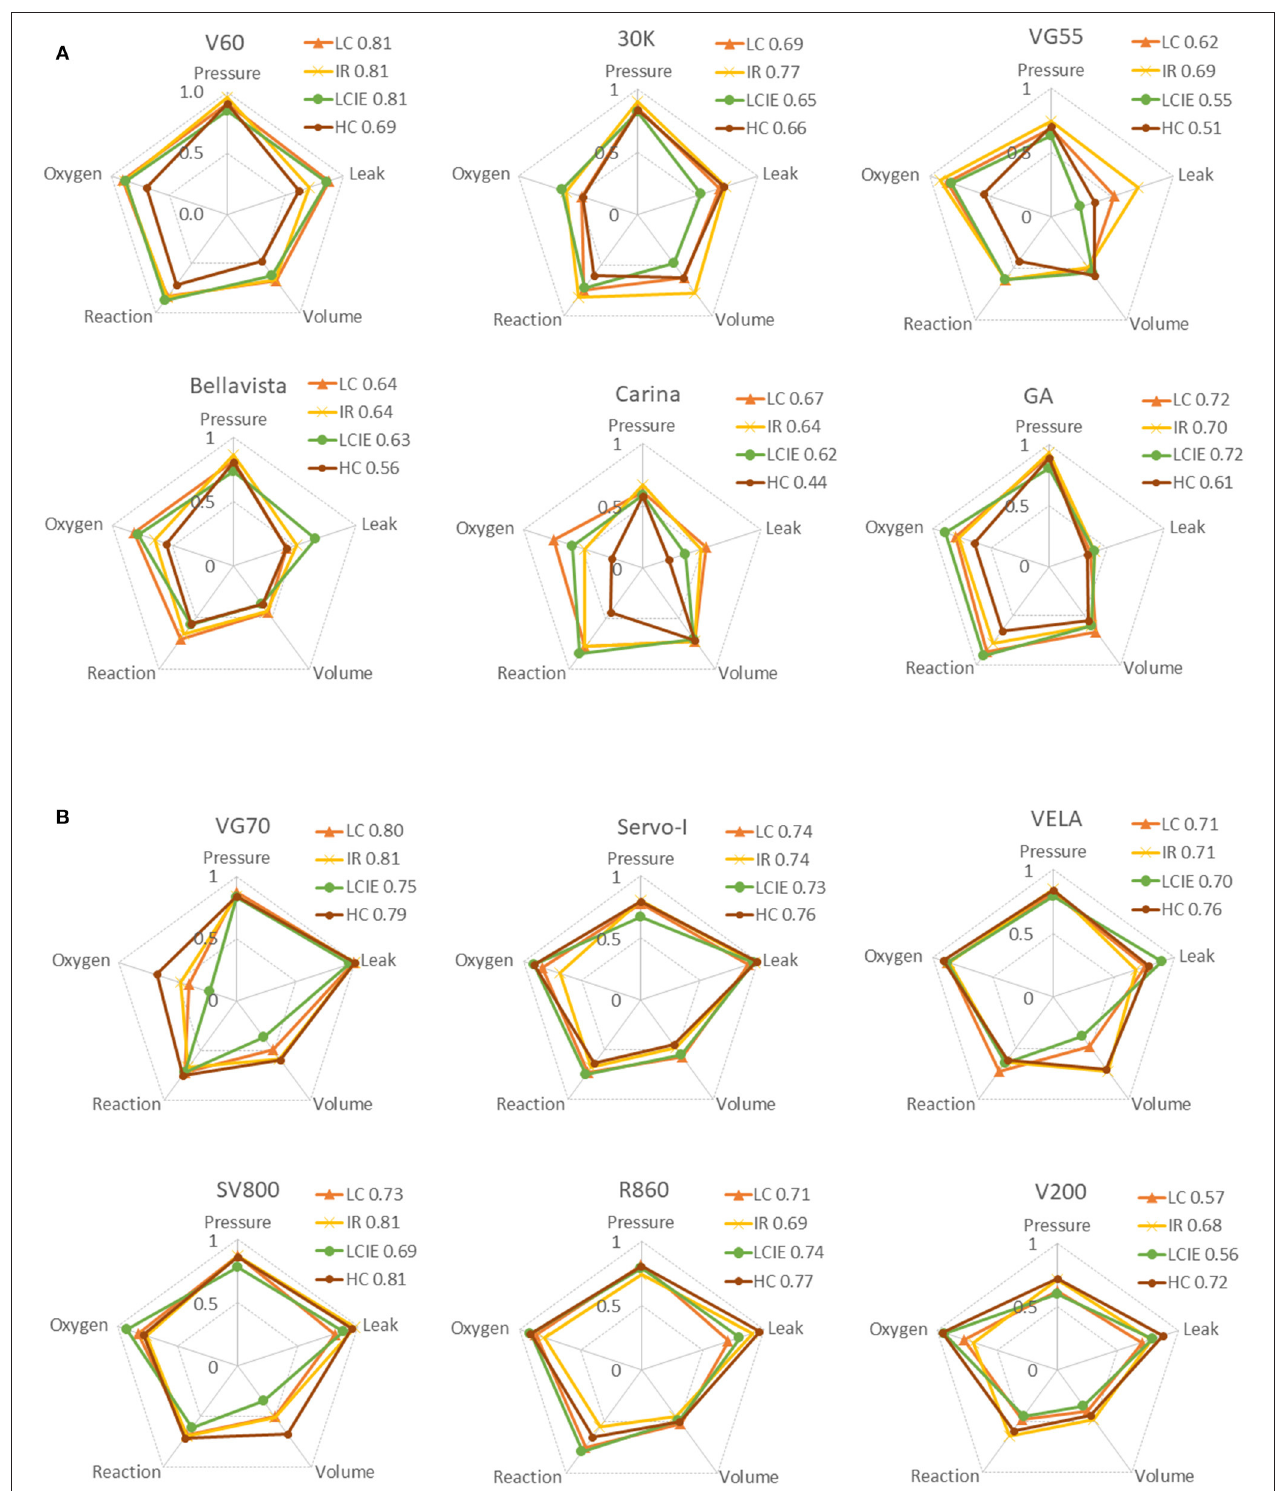
FIGURE 4 | Radar charts summarizing the main criteria of the performance evaluation. Data are expressed as the score calculated based on the proposed scoring system. Scores for three simulated COVID-19 phenotypes are superimposed on the same chart (IR, increased airway resistance; LC, low compliance; LCIE, low compliance plus increased respiratory effort; HC, high compliance). The following five characteristics are summarized for each ventilator (clock-wise): the stability of pressurization (pressure), response to leaks alteration (leak), volume delivery (volume), performance of reaction (reaction), and accuracy in oxygen delivery (oxygen). (A) Non-invasive ventilators with single-circuit connection. (B) ICU ventilators with non-invasive ventilation mode and double-circuit connection.